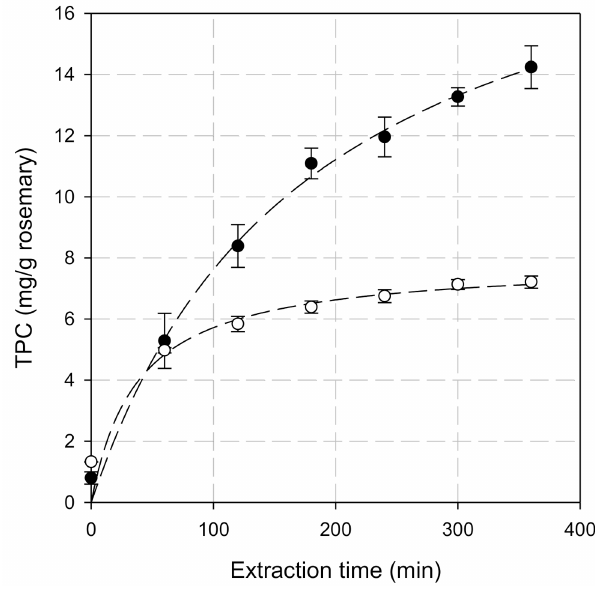
) conventional extraction (50% v / v ethanol) and (cid:35)